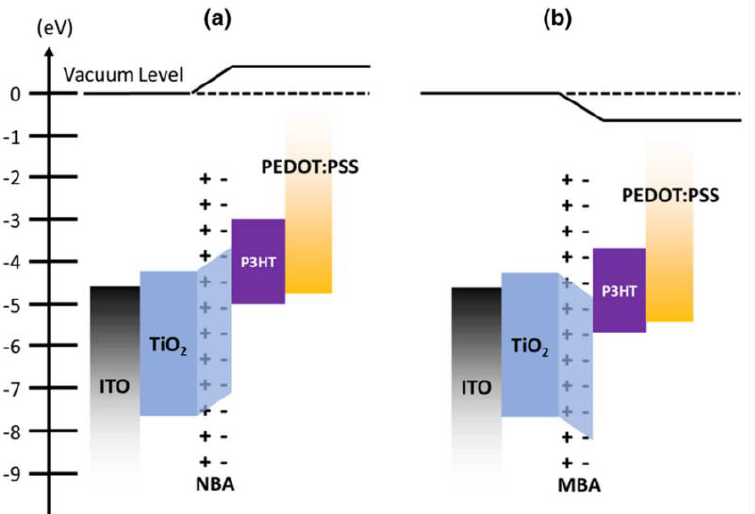
Figure 3. Energy band diagrams for energy level shifting of SAMs at the TiO 2 /P3HT interface of ITO/TiO 2 /SAMs/P3HT/PEDOT:PSS/Au device. NBA and MBA are 4-Nitro Benzoic Acid and 4-Methoxy Benzoic Acid, respectively [14]. Figures ( a , b ) are energy band diagrams for energy level shifting of NBA and MBA treated devices, respectively.